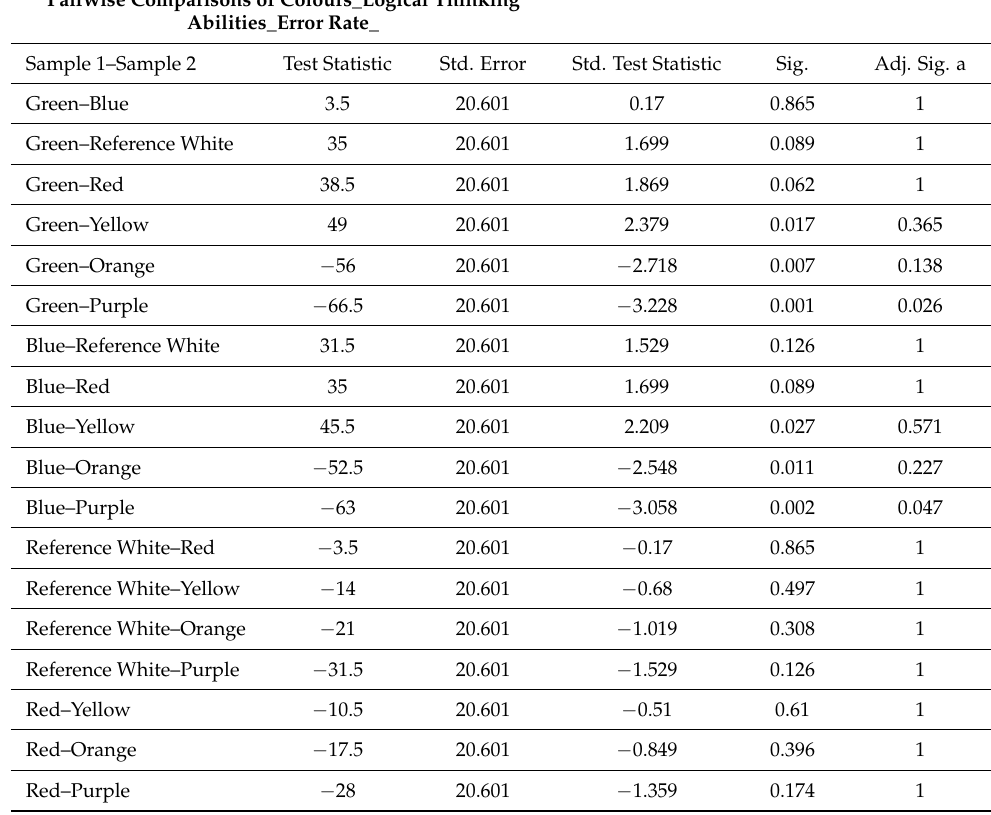
Table A14. Effects on error rate (logical thinking